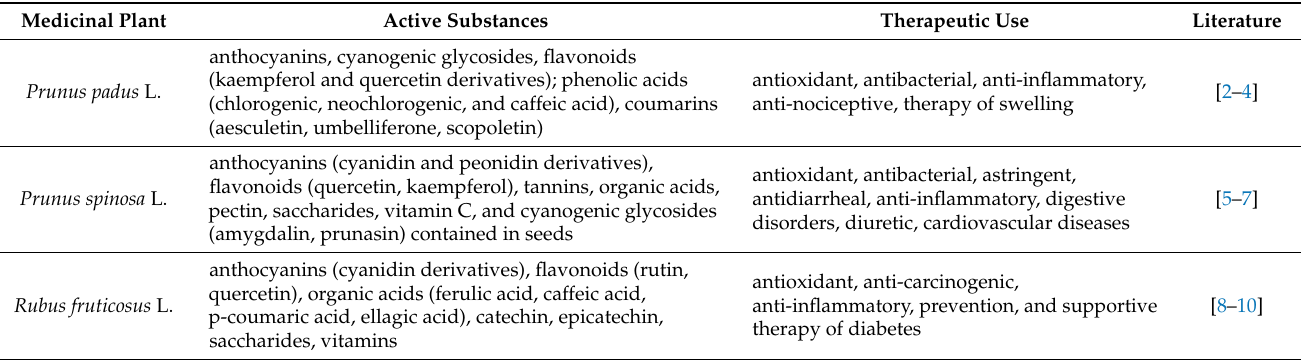
Table 1. Overview of the used medicinal plants, main active substances, and their therapeutic use. Medicinal Plant Active Substances Therapeutic Use